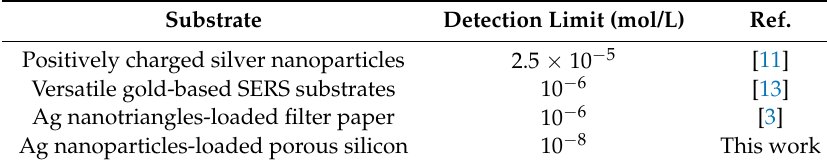
Table 2. Summary of reported detection limits obtained using SERS technique for PA sensing.